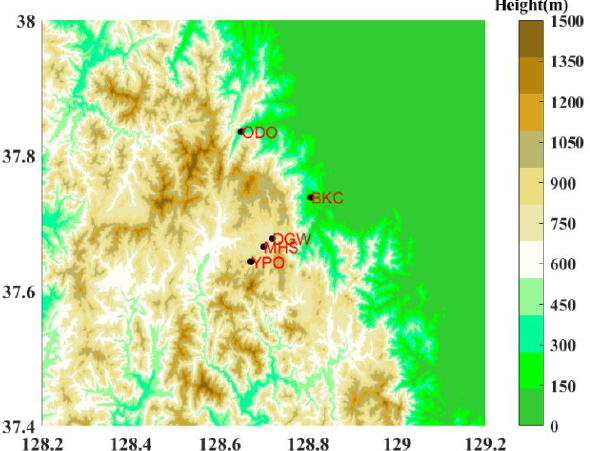
Figure 1. The locations of Parsivel 2 disdrometers and Precipitation Imaging Package (PIP) used during ICE-POP 2018 in this study. Parsivel 2 disdrometers were located at YPO, ODO, and DGW sites, and PIPs were located at MHS and BKC sites.